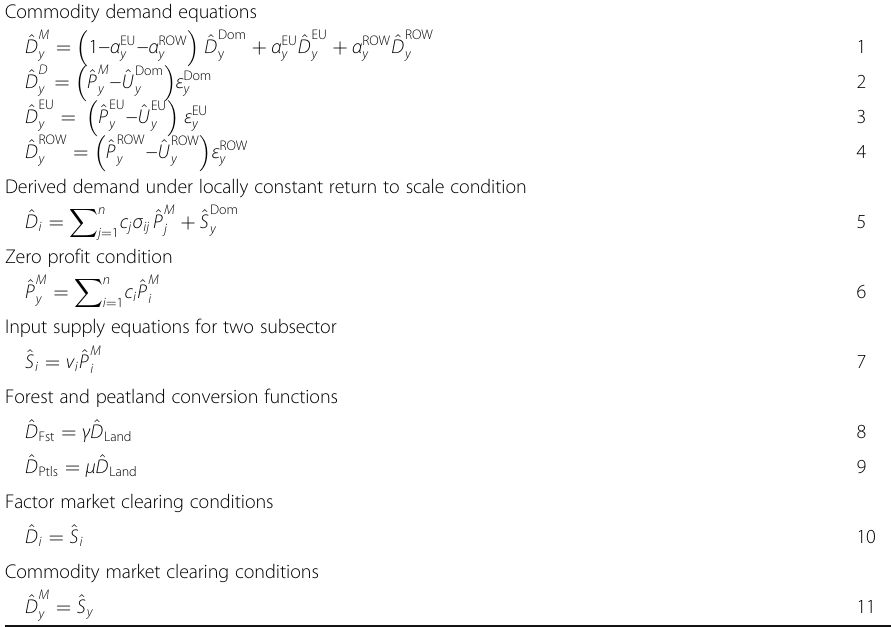
Table 5 Single commodity partial equilibrium model of the Indonesian oil palm Commodity demand